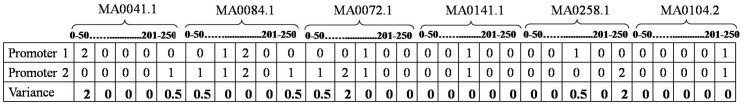
Example feature matrix of PSMMs of promoters 1 and 2.